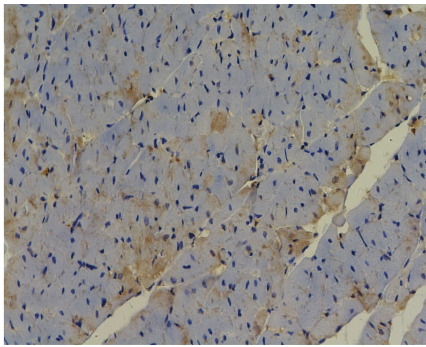
Figure 5: Baicalin-treated group-3h Bcl-2 × 200 (positive expres- sion).